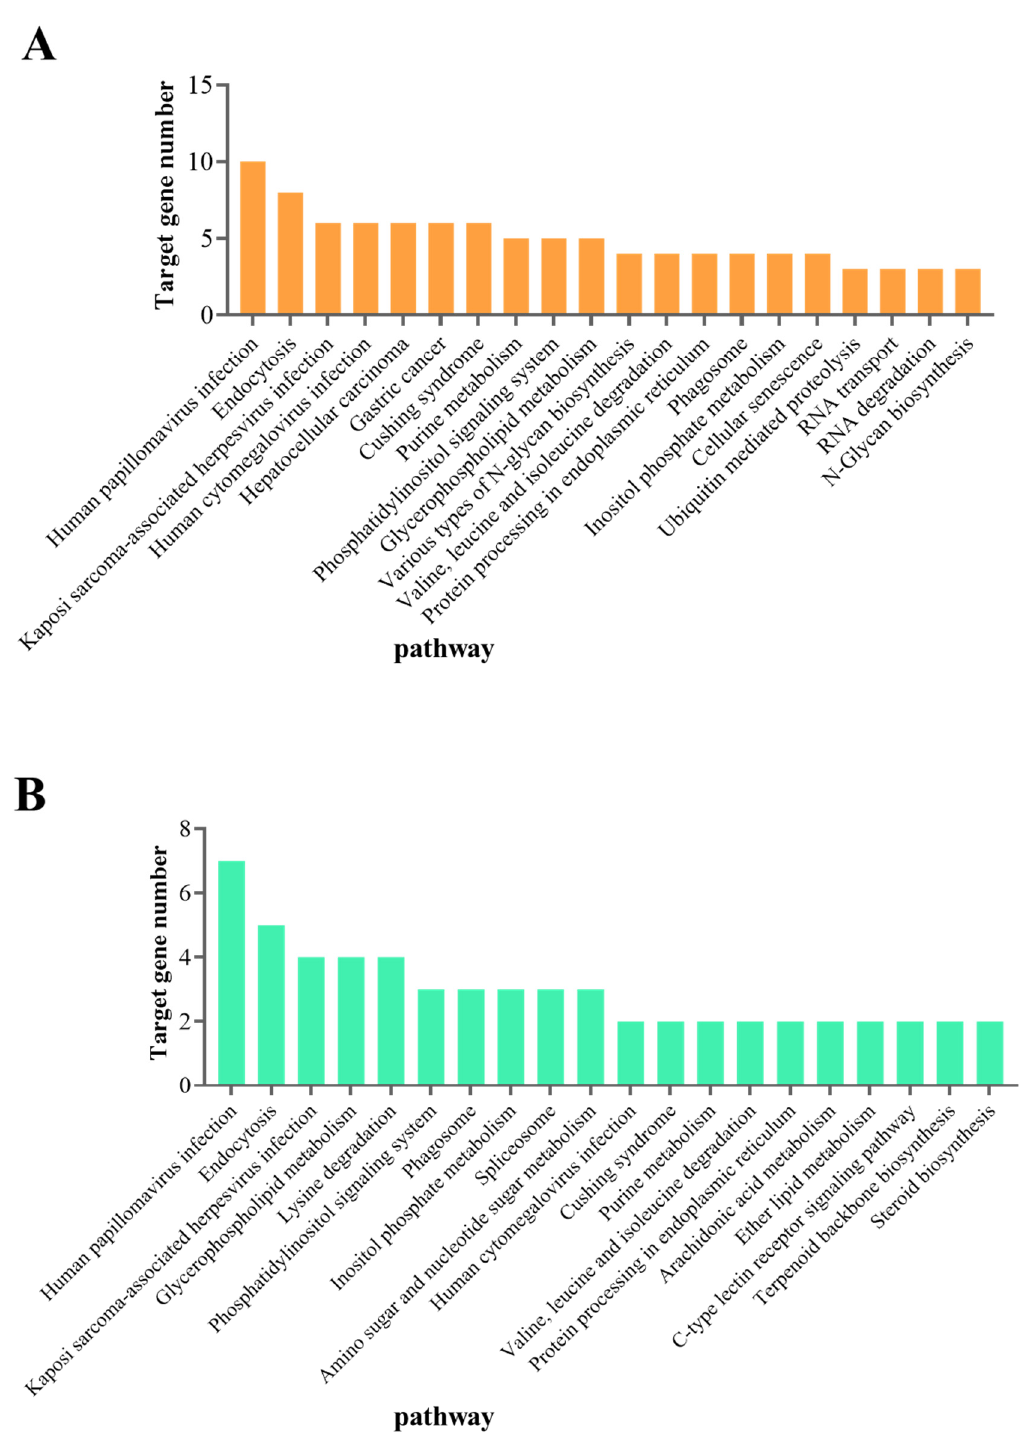
Figure 3. The 20 KEGG pathways most enriched in the DEmiRNA target genes at 12 h ( A ) and 24 h ( B ) . The x and y axes show the KEGG pathways and the number of associated DEmiRNA target genes, respectively.